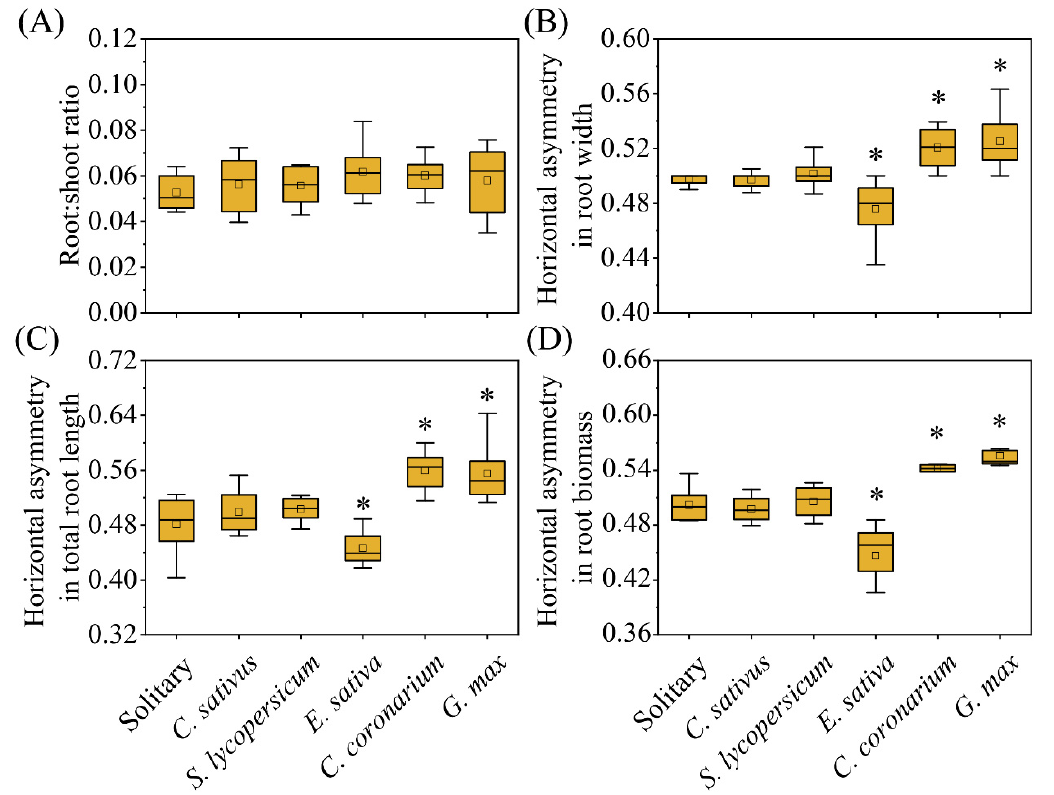
Figure 3. The allocation responses of C. sativus to different competition treatments. * indicates a significant difference in ( A ) root:shoot radio, ( B ) horizontal asymmetry in root width, ( C ) horizontal asymmetry in total root length, and ( D ) horizontal asymmetry in root biomass between competition and solitary treatment ( p < 0.05).